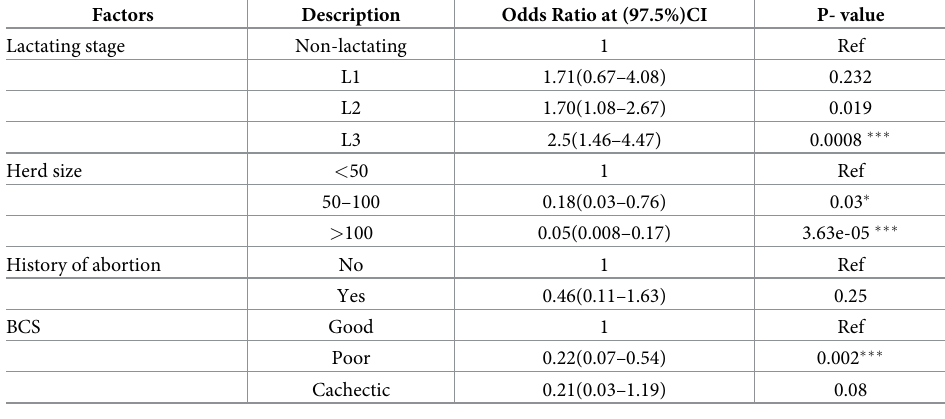
Table 2. Multivariable logistic regression model for brucellosis sero-prevalence and associated herd management factors in Bahr el Ghazal region, South